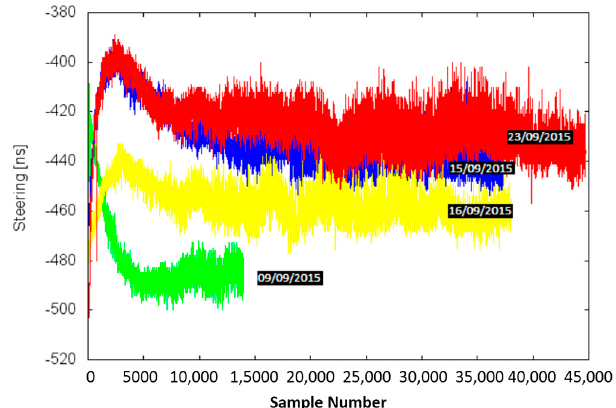
Figure 8. CSAC time drift evaluation.